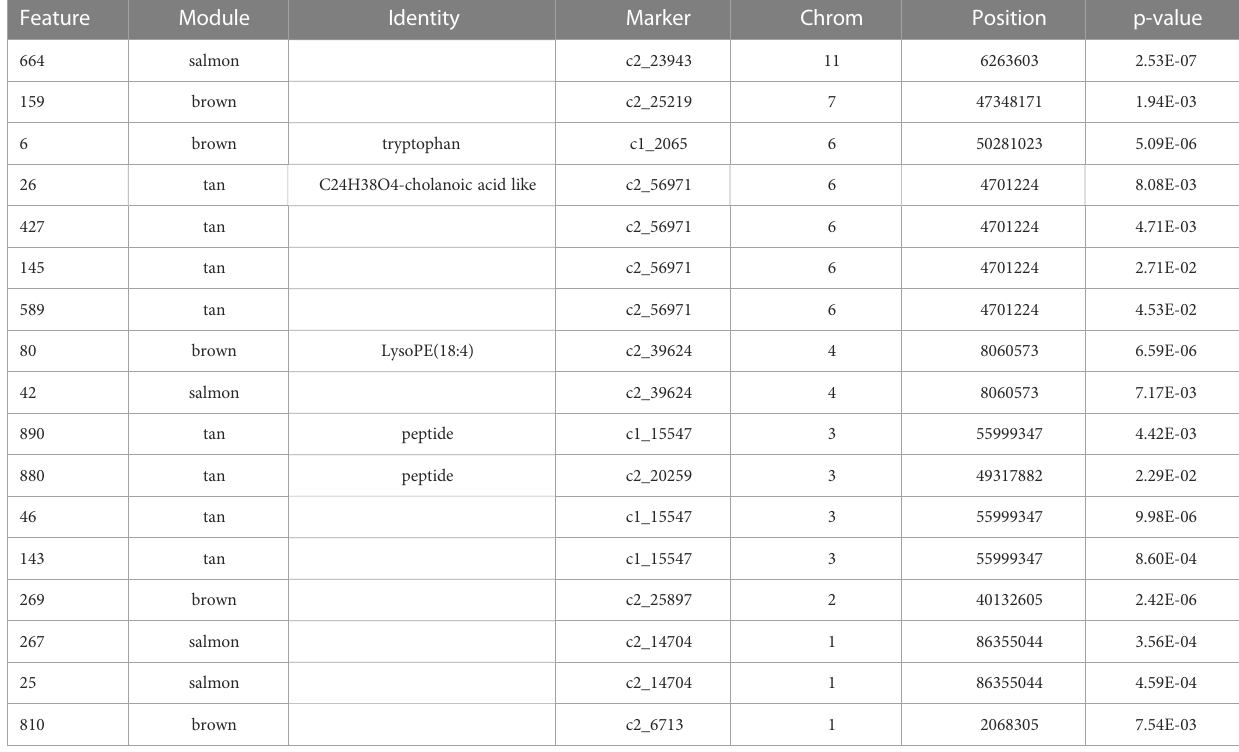
TABLE 3 Features that were signi fi cantly associated at Bonferroni corrected p-value with both chip score and one or more SNPs.